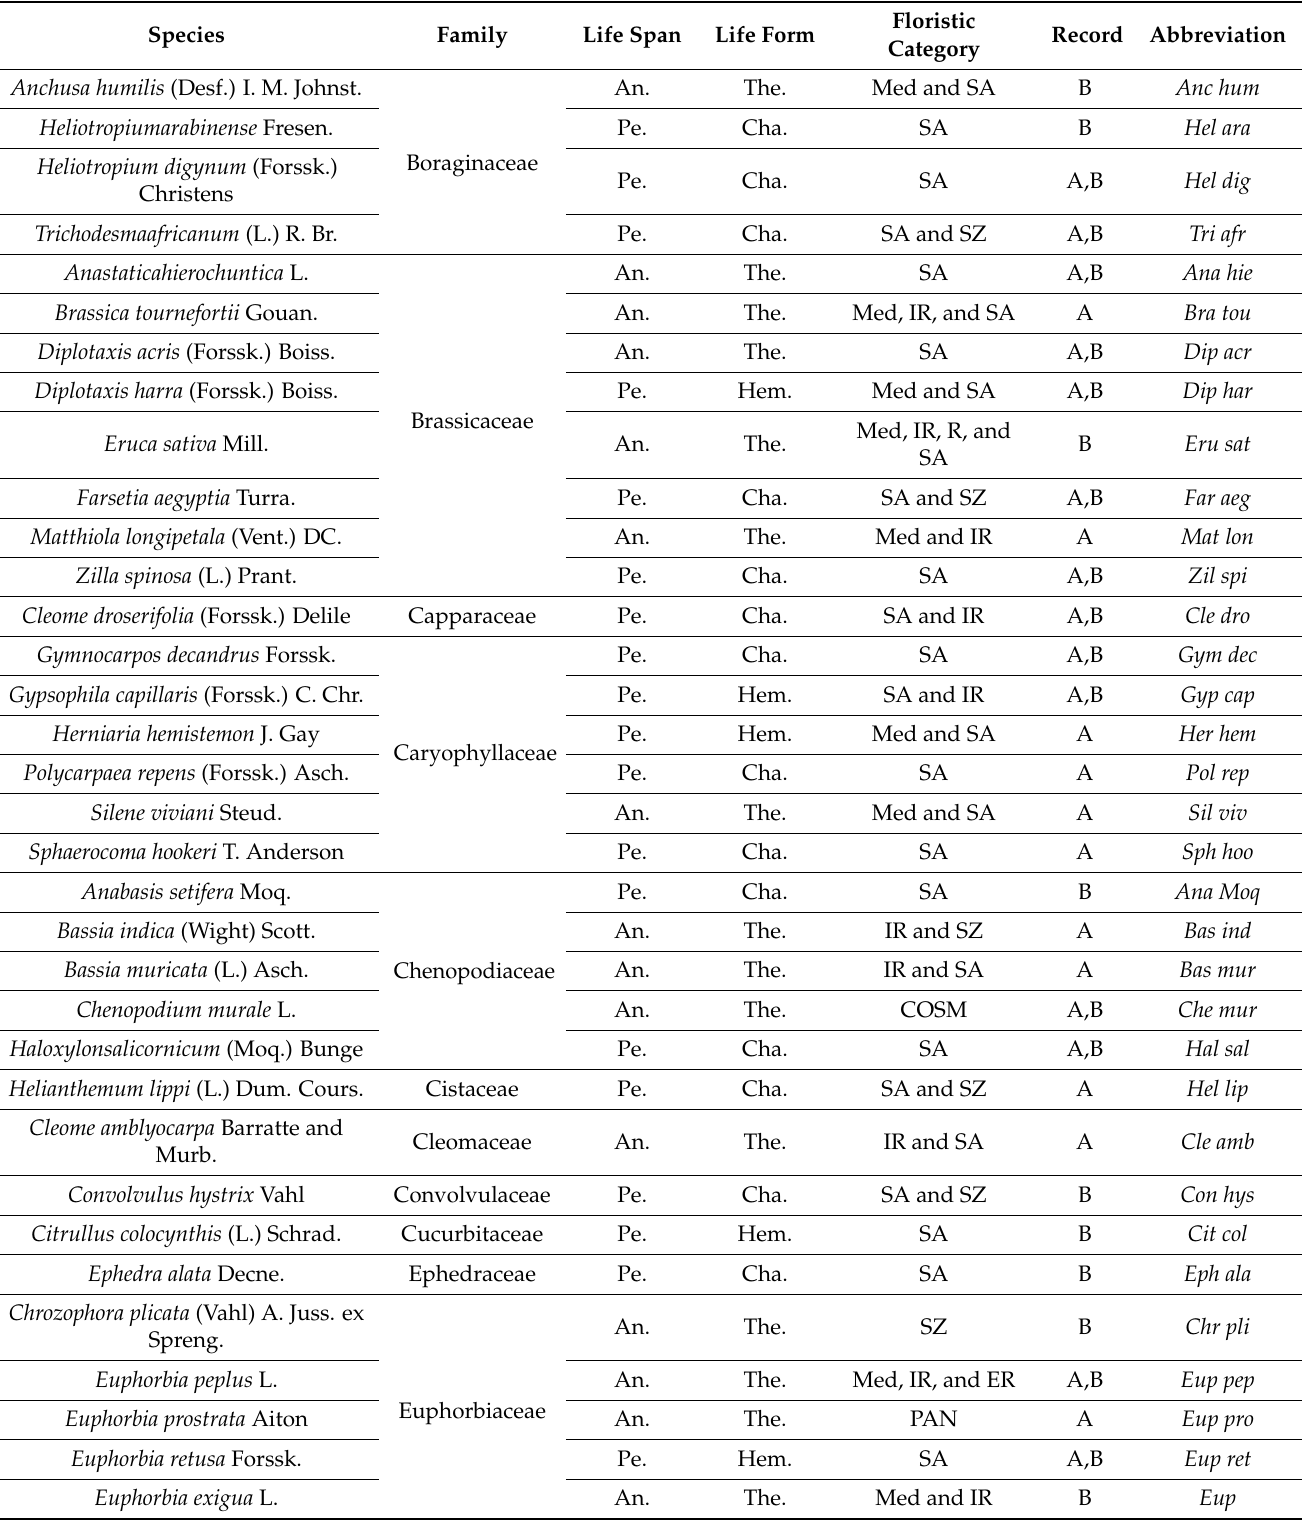
Hem. B Eph ala An. The. SZ B Chr pli Euphorbia peplus L. An. The. Med, IR, and ER A,B Eup pep Euphorbiaceae Euphorbia prostrata Aiton An. The. PAN A Eup pro Euphorbia retusa Forssk. Pe. Hem. SA A,B Eup ret Euphorbia exigua L. An. The. Med and IR B